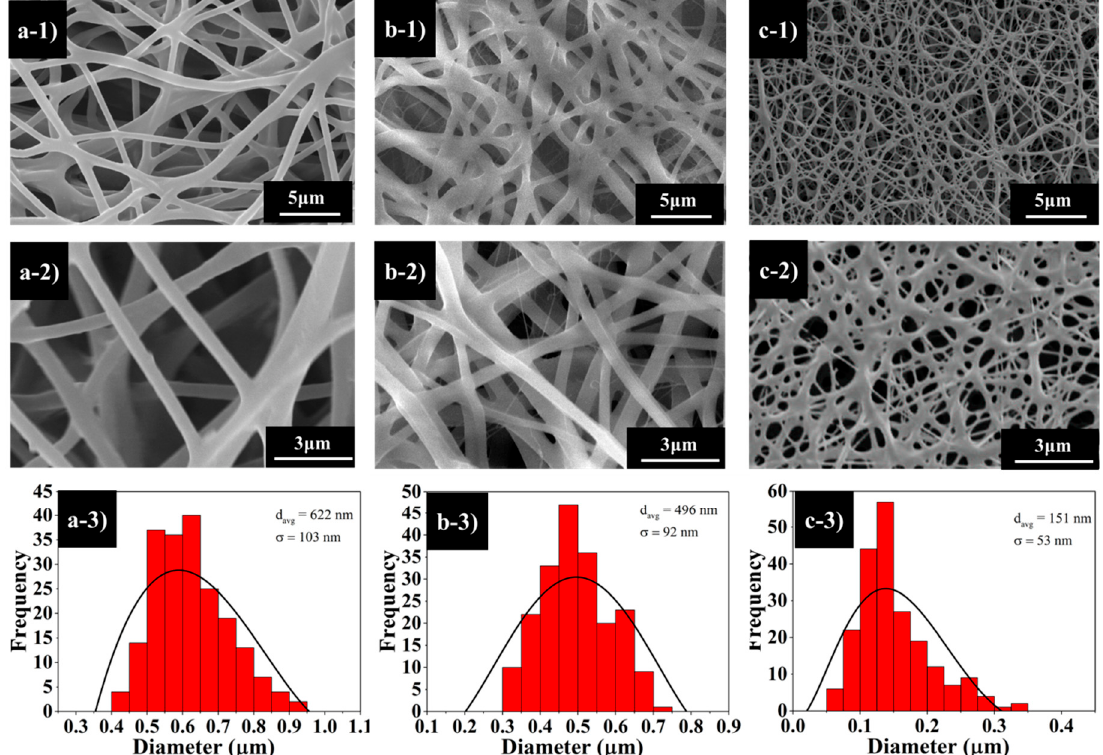
Figure 3. The scanning electron microscope (SEM) images of electro-spun PCL–PDMS